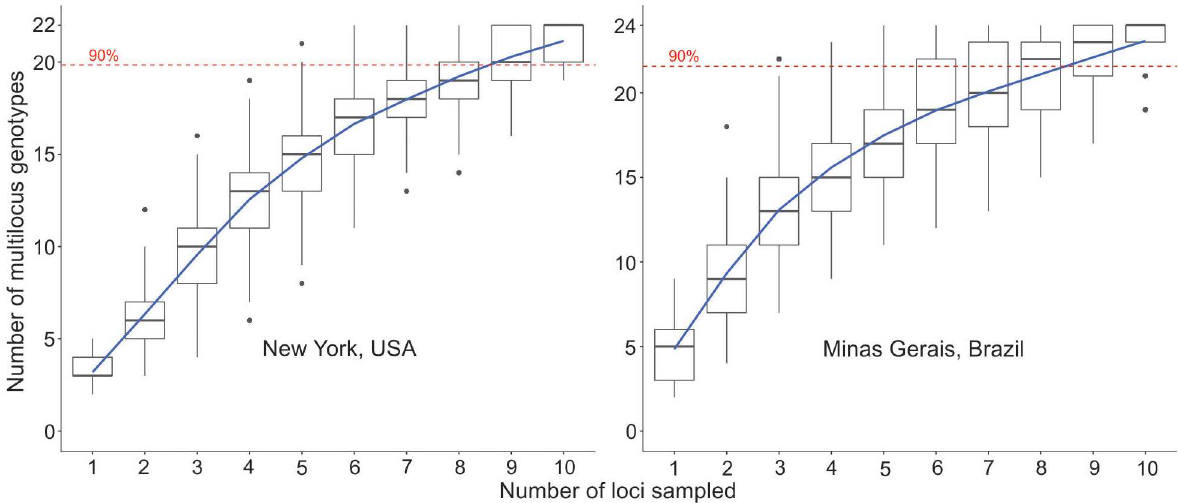
Fig 3. Genotype accumulation curves for the Sclerotinia sclerotiorum populations from New York, United States (USA) and Minas Gerais, Brazil. The number of loci was randomly sampled(1,000 times) without replacement up to n − 1 loci. The 90% of the number of multilocusgenotypesidentifiedin each population are indicatedby